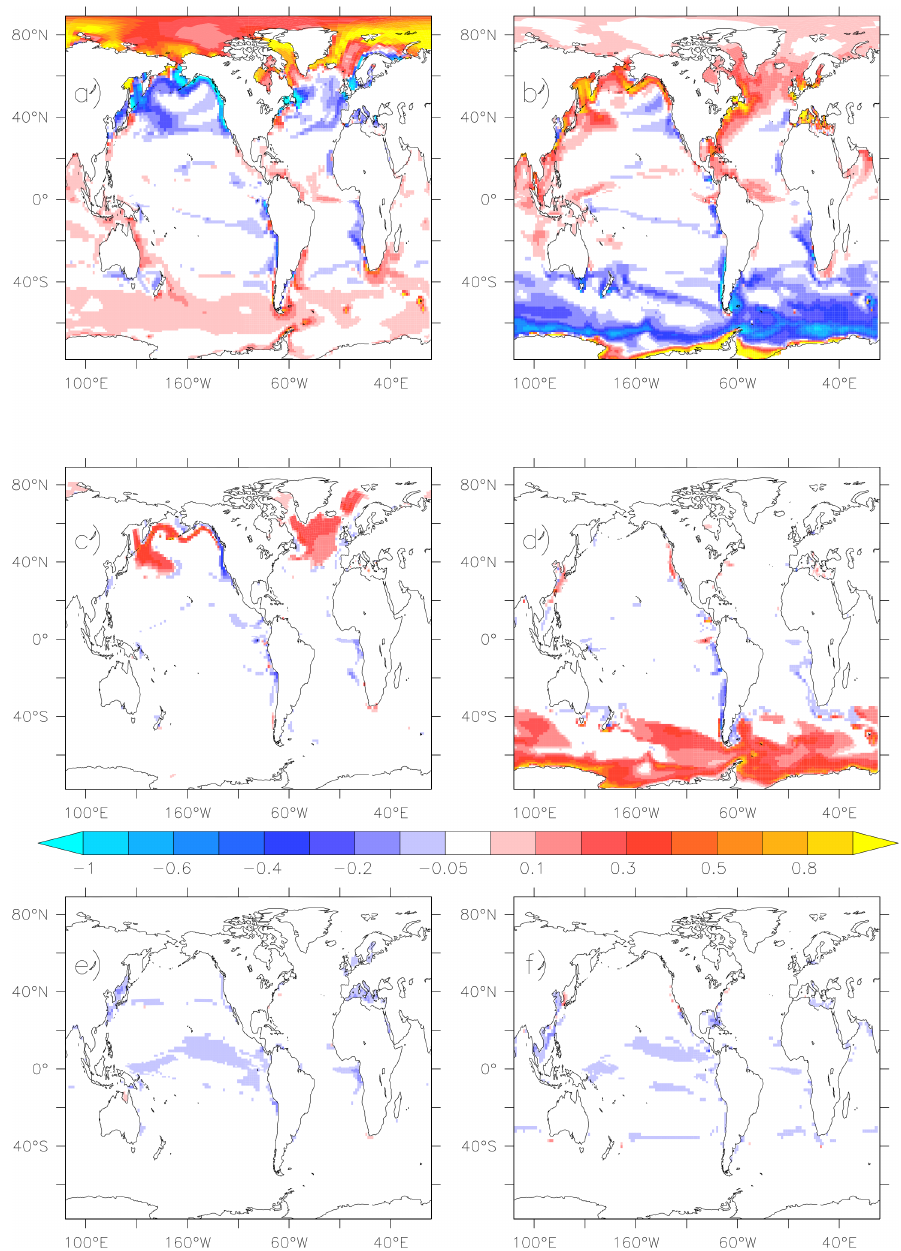
Figure 17. Surface seasonal mean chlorophyll anomaly (mgchl a m − 3 ) relative to the standard simulation in April-May-June (left column) and November-December-January (right column). Panels (a) and (b) correspond to the LIGHT test; panels (c) and (d) show to the SIZE test; panels (e) and (f) display the FOOD